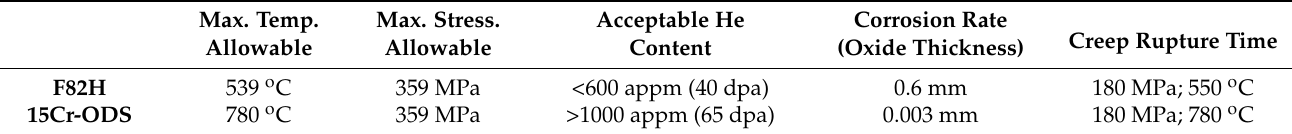
Table 4. Performance comparison between RAFM and ODS. Adapted from Ref. [100]. Max.